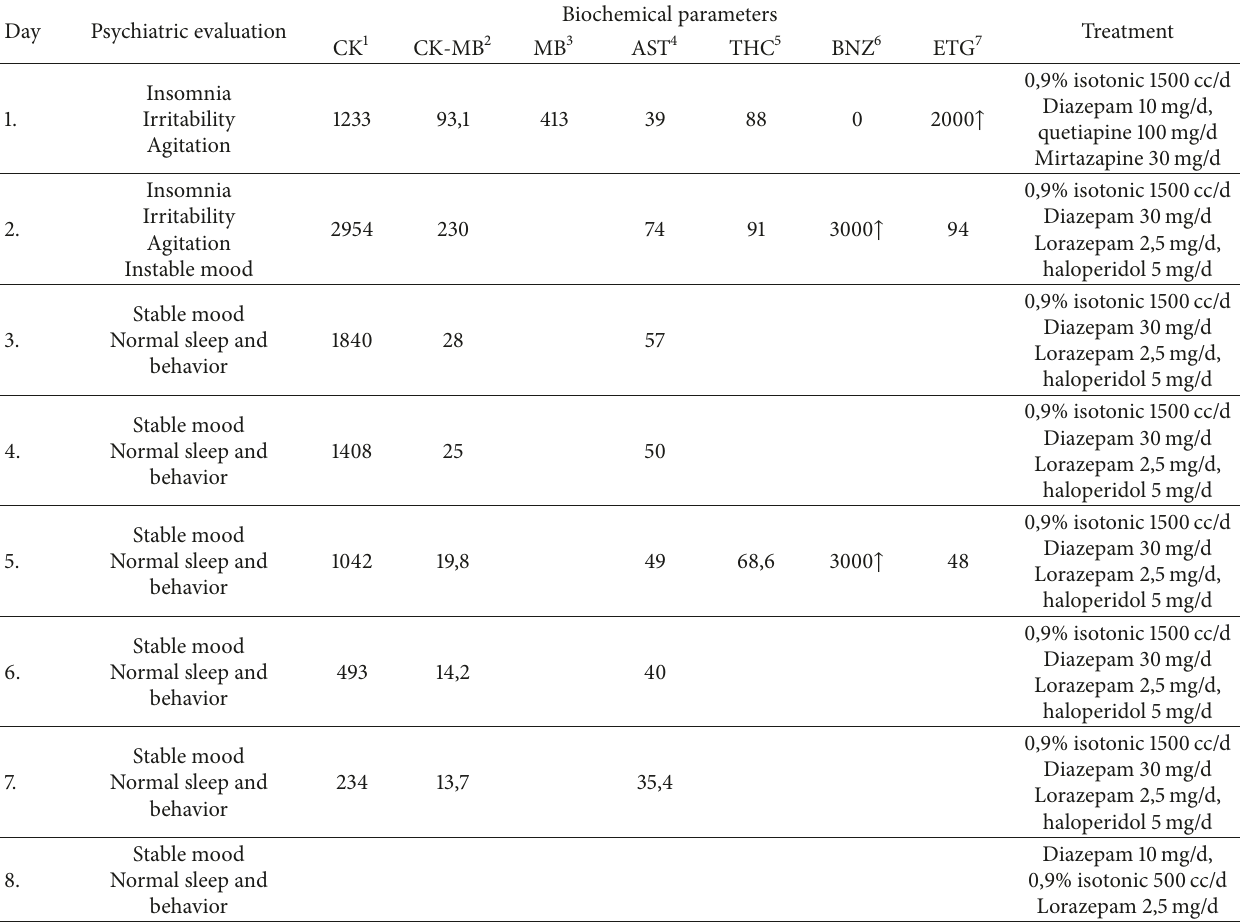
Table 3: Case 2 clinical observation and